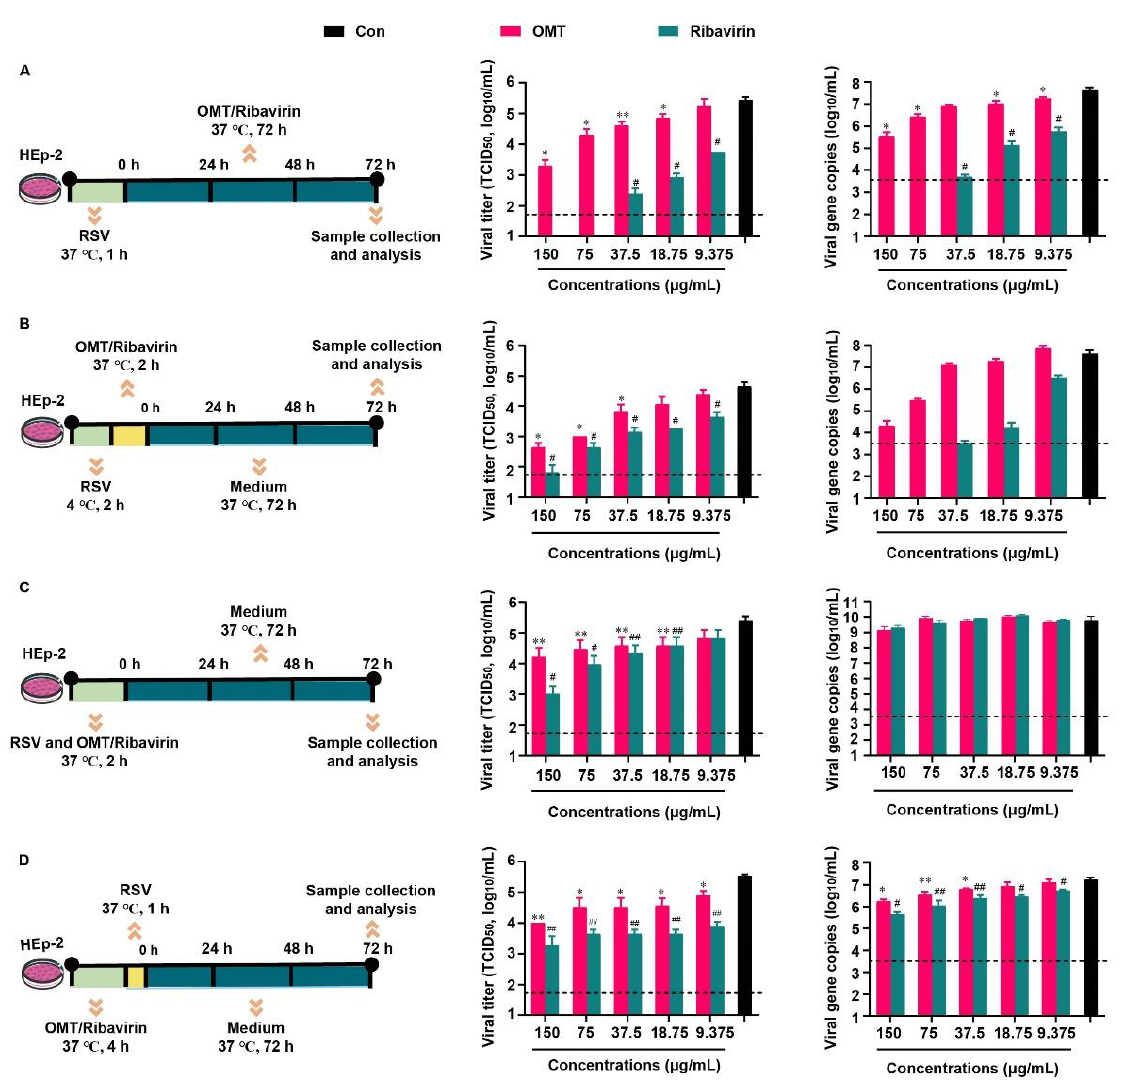
Figure 2. Inhibitory effects of OMT on RSV infection and replication in HEp-2 cell. The experimental scheme, TCID 50 and qRT-PCR result of ( A ) virus biosynthesis assay, ( B ) virus penetration assay, ( C ) virus attachment assay, and ( D ) drug pre-treatment assay. All the data were expressed as mean + SD ( n = 3). * and ** represent OMT compared with virus control (black bar) as p < 0.05 and p < 0.01; # and ## represent ribavirin compared with virus control (black bar) as p < 0.05 and p < 0.01. The dash line indicates the limit of detection in TCID 50 assay and qRT-PCR assay, respectively. Con: virus control.